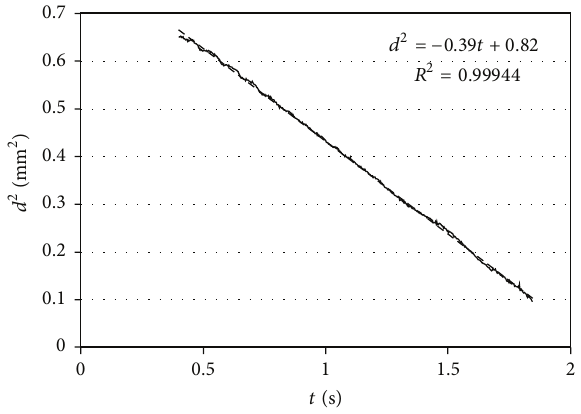
Figure 6: Representative plot of 𝑑 2 versus 𝑡 and the curve fit used to calculate the burning rate 𝐾 for a heptane/methanol droplet in air. The dashed line is the curve fit and the solid line is the experimental data.